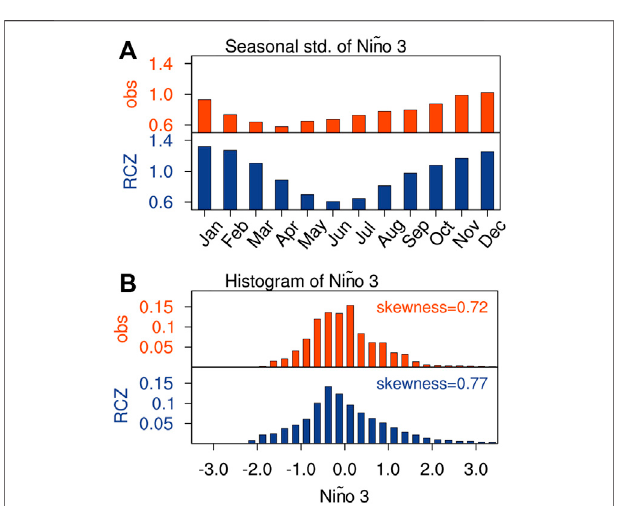
FIGURE 11 | The standard deviation of SSTA (unit: ° C) in (A) the observations and (B) the 5000-year RCZ coupled simulation. The observed standard deviation is calculated with the HadISST dataset covering 1900 – 2018.